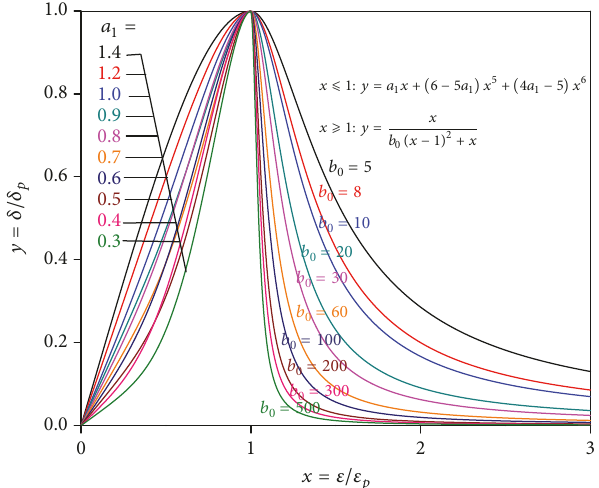
Figure 14: The calculating curve of constitutive model.